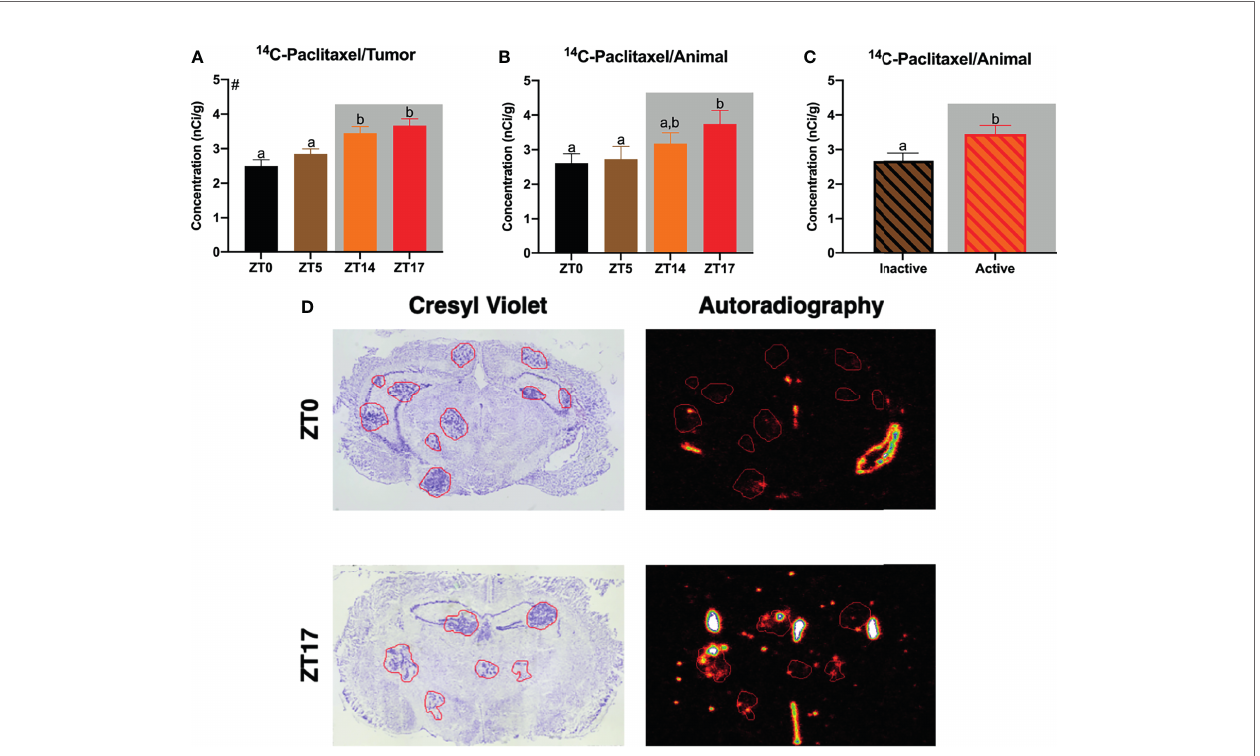
FIGURE 1 | Daily alterations in 14 C-paclitaxel within JIMT-1BR3 BMBC. (A) When examining all tumors independently, mice receiving paclitaxel injections at ZT14 or ZT17 demonstrated signi fi cantly increased 14 C-paclitaxel concentrations within BMBC relative to mice receiving paclitaxel injections at ZT0 or ZT5. (B) When examining animal averages, planned comparisons demonstrate an increase in 14 C-paclitaxel concentrations within BMBC at ZT17 relative to ZT0 or ZT 5. (C) Additionally, when combining groups and assessing animal averages based on activity, mice that received paclitaxel injections during their active phase displayed signi fi cantly increased 14 C-paclitaxel concentrations within BMBC. (D) Representative cresyl violet and autoradiography images for ZT0 and ZT17. [ (A) n= 122, 269, 185, 142 respectively; (B) n= 9, 9, 9, 8 respectively; (C) n= 18, 17 respectively]. The data are presented as mean +SEM. Graph bars that do not share a letter are statistically signi fi cantly different at p<0.05. # Main effect of time of injection; (A) nonparametric Kruskal-Wallis test; Dunn ’ s multiple comparisons test (B) one-way ANOVA; Fisher ’ s LSD multiple comparisons test (C) unpaired t